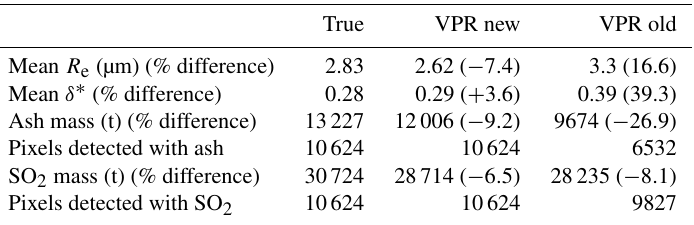
Table 5. Main characteristics of synthetic image, indicated as “true”, together with the results of the VPR procedure, both new and old versions. The percentage differences are shown in brackets.